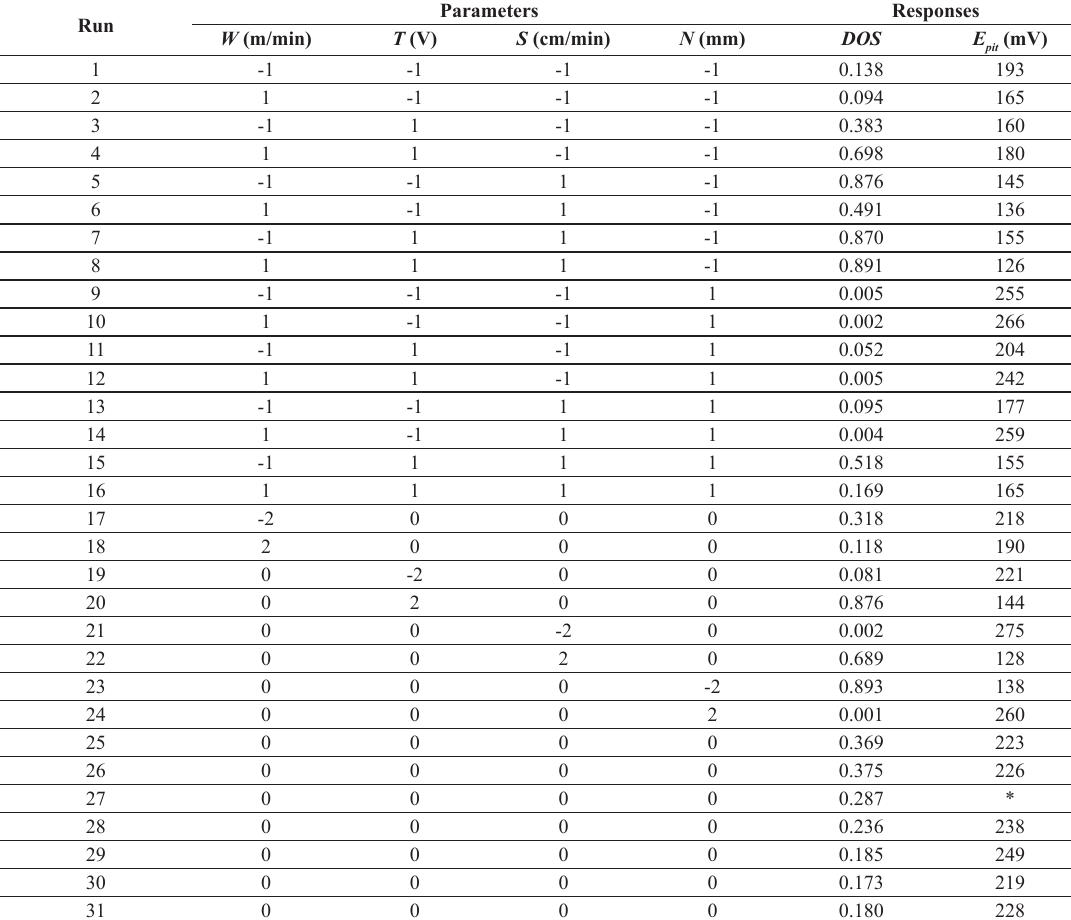
Table 3. Design matrix and responses.